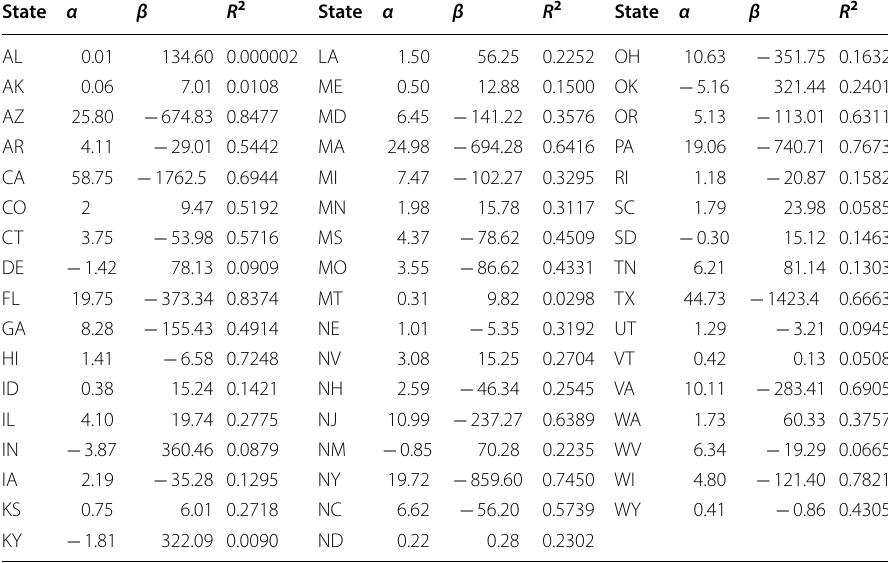
Table 10 Coefficients α, β, and R 2 of the linear regressions for Hepatitis cases State